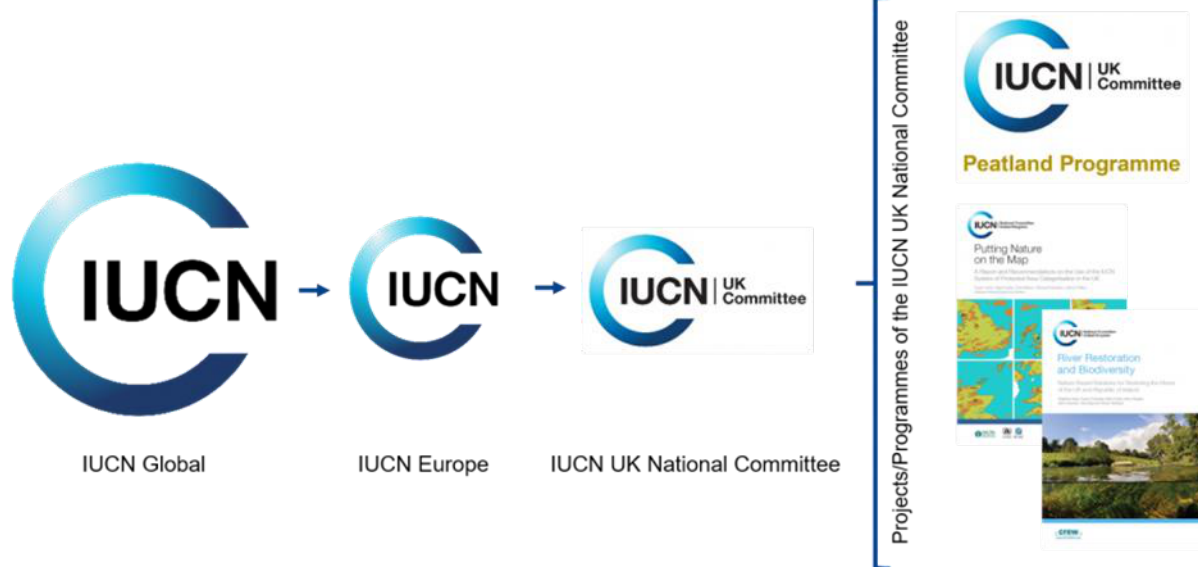
Figure 1. Governance hierarchy showing how the boundary organisation studied fits within the wider structures of its parent